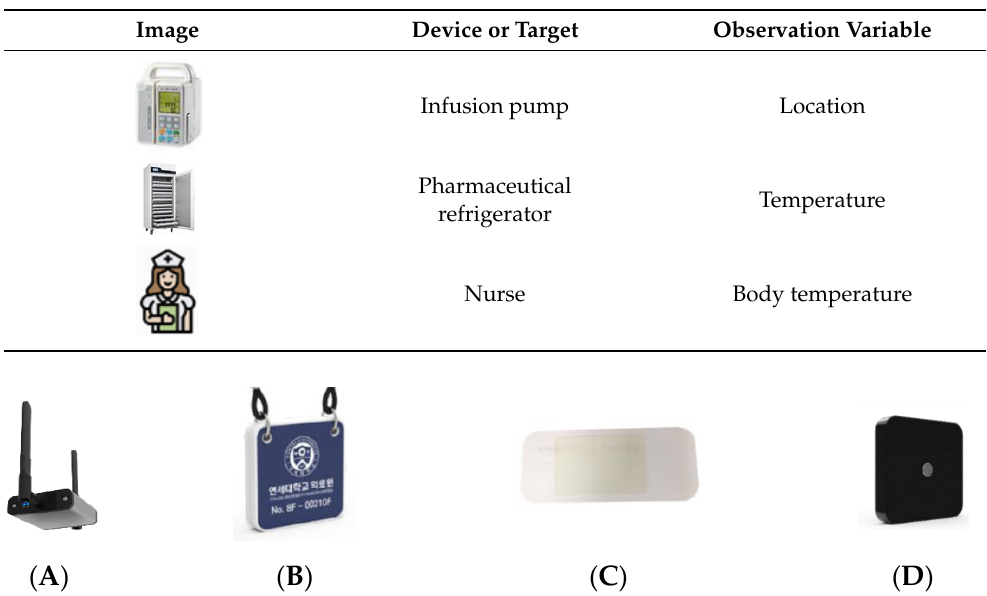
Table 4. Monitoring Targets.